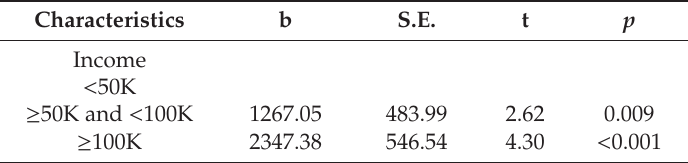
Table 2. E ff ects of household income level on the whole-brain cortical surface